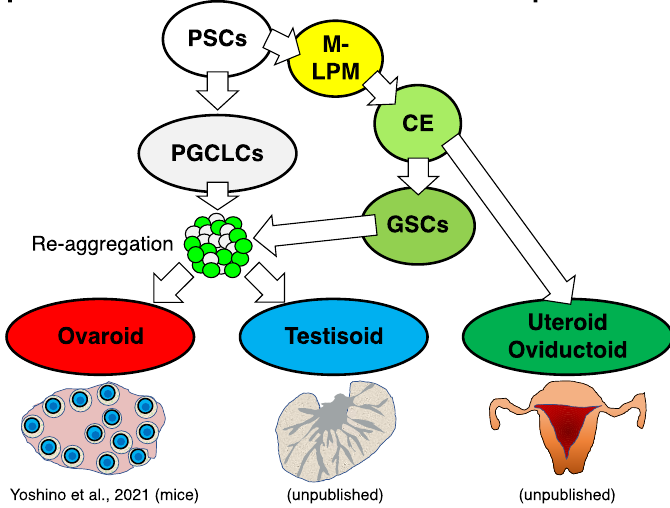
Figure 5. Potential approaches for in vitro reconstitution of reproductive organs. M-LPM, media- lateral plate mesoderm; CE, coelomic epithelium.